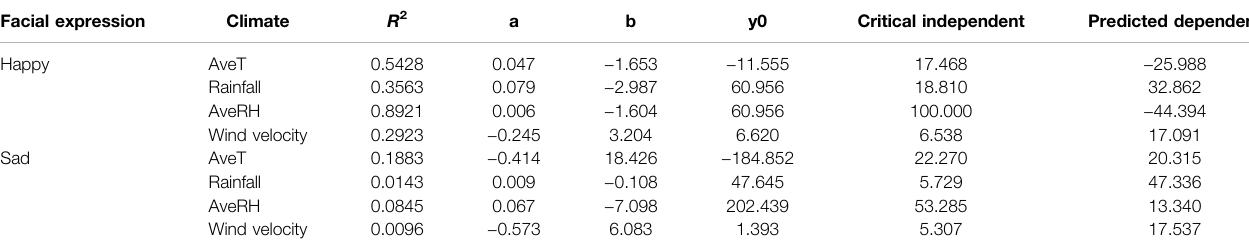
TABLE 2 | Coef fi cients from binomial regressions of climatic factors on maximum likelihood parameter (MLP) estimates on happy and sad scores. Facial expression Climate R 2 a b y0 Critical independent Predicted dependent